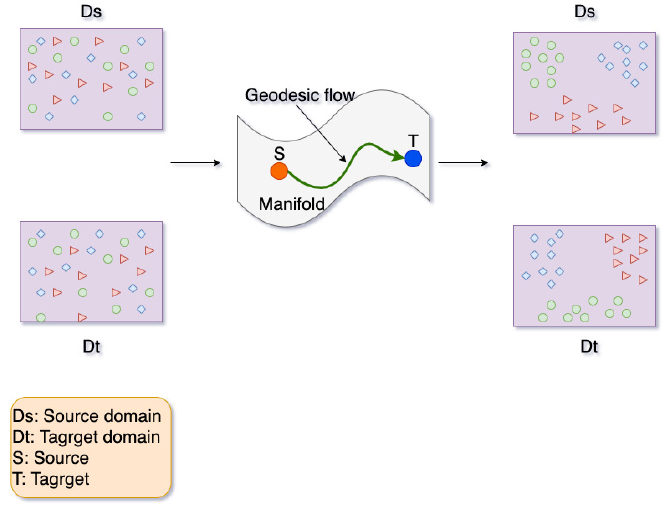
Figure 7. The structure of manifold